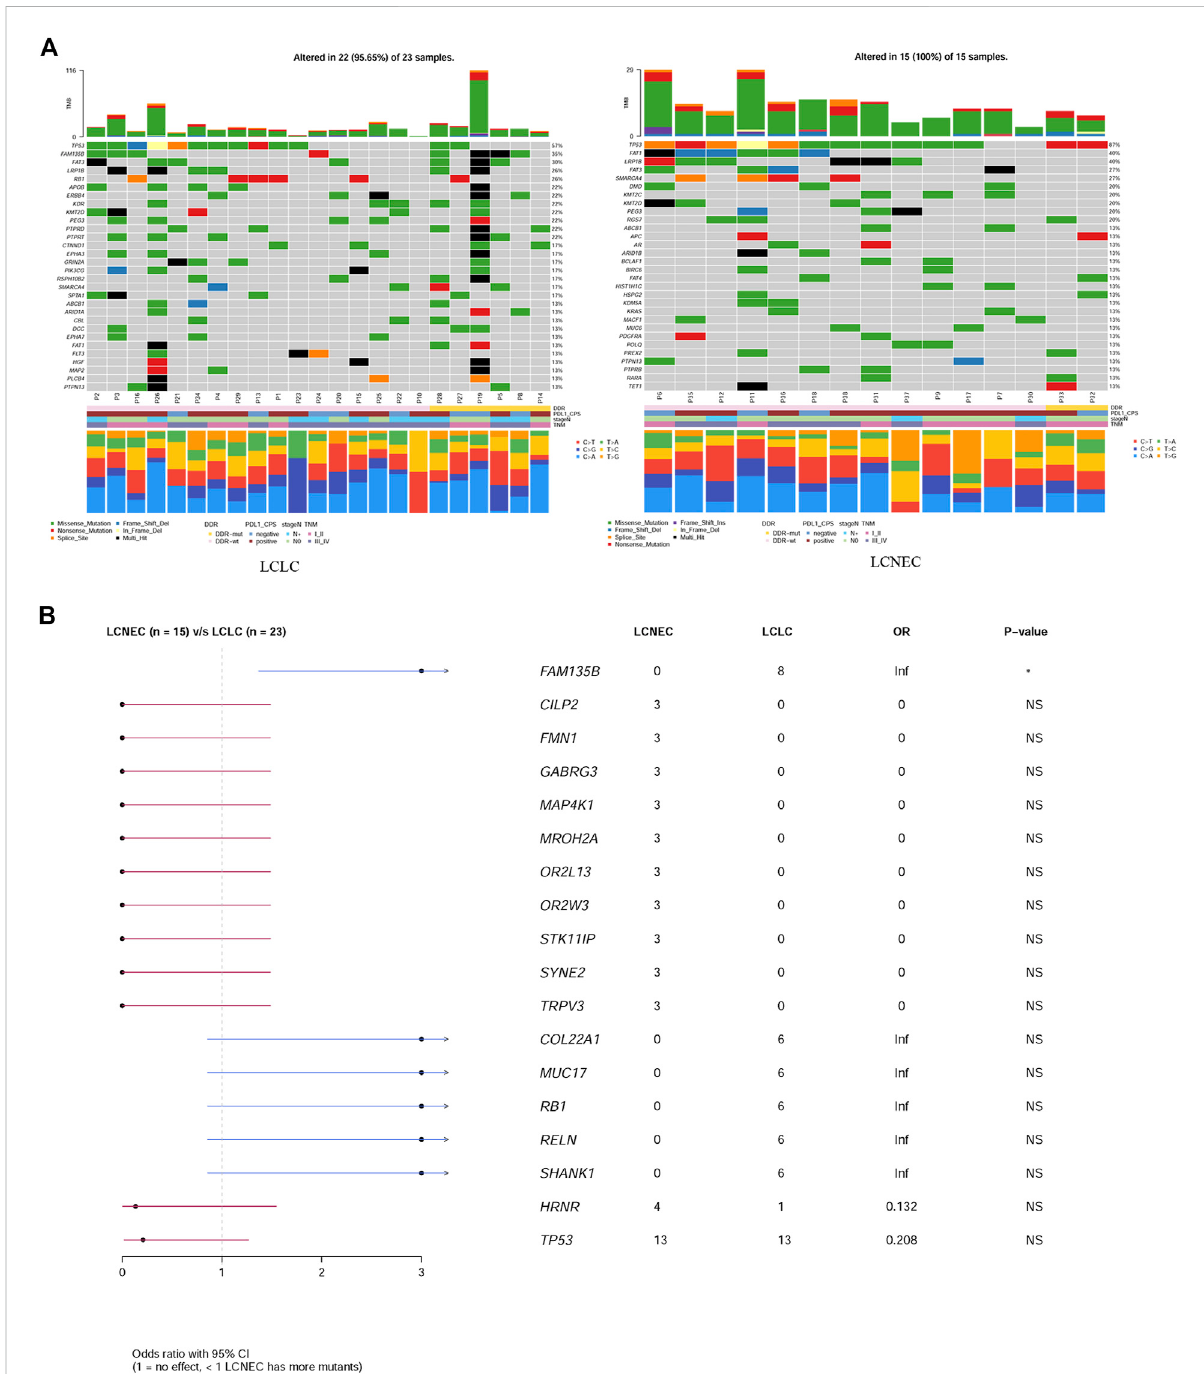
FIGURE 1 ComparisonofmutationlandscapebetweenLCLCandLCNEC. (A) AcomparisonofthemutationallandscapesofLCLCandLCNECisprovided, along with the most frequently mutated driver genes. The top panel represents the TMB and the middle panel represents the matrix of frequently mutatedgenes.Columnsrepresentsamples,andclinicopathologicalcharacteristicsofindividualpatientsarepresentedbelow.Barplotsinthelower panel shows the contribution of six substitutions. (B) Forestplot shows the signi fi cant differences of driver genes between the two